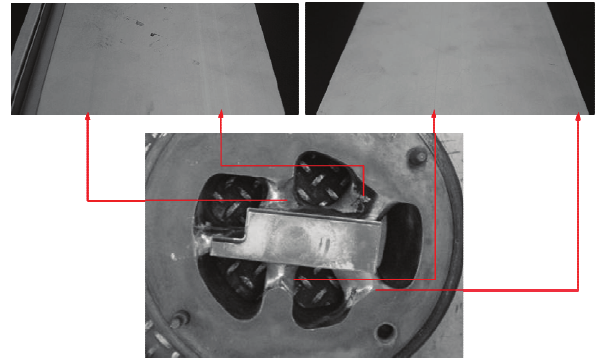
Figure 3. Streaks due to longitudinal extrusion welds. The welds are formed due to splitting and rejoining of the metal flowing through the webs of the die. Arrows link the streaks with the corresponding webs of the